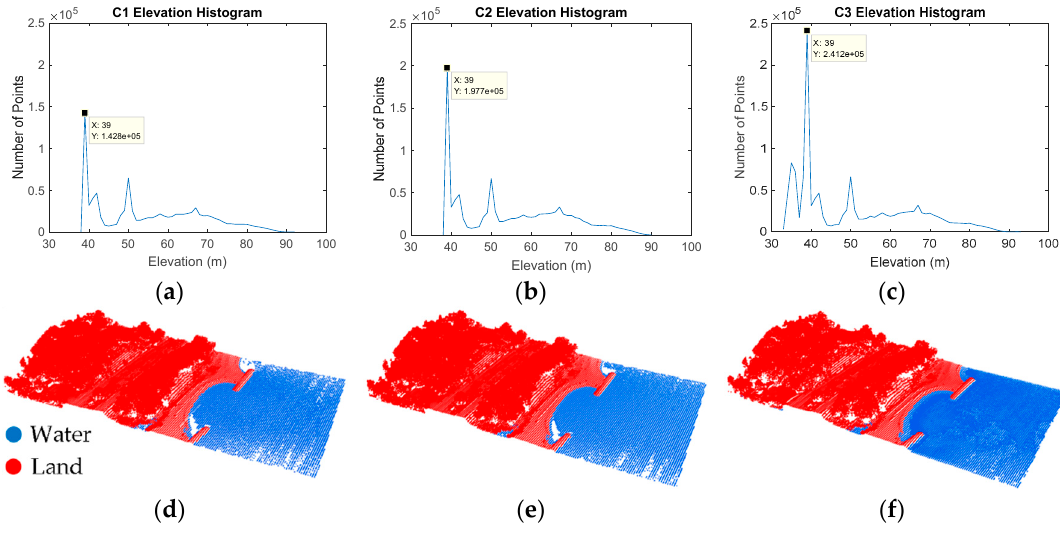
Figure 4. Elevation histogram of ( a ) C1; ( b ) C2; and ( c ) C3; and labeled LiDAR points based on elevation using ( d ) C1; ( e ) C2; and ( f ) C3.